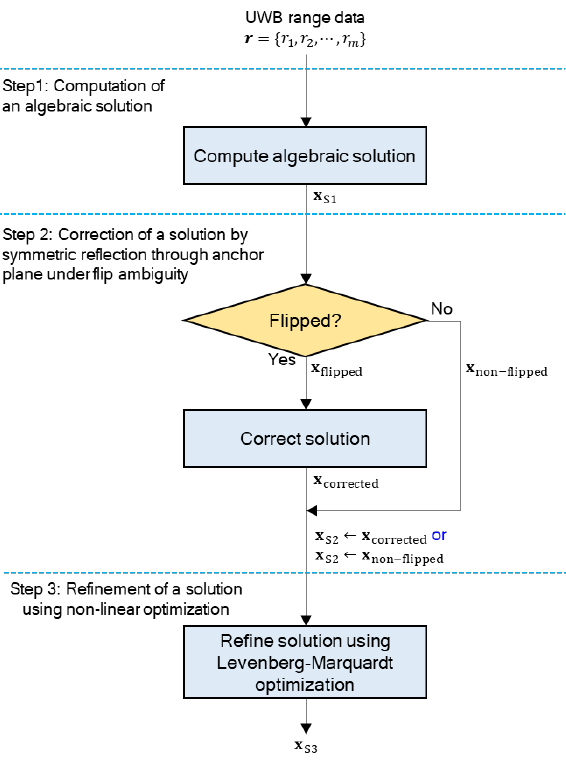
Figure 3. Proposed multilateration